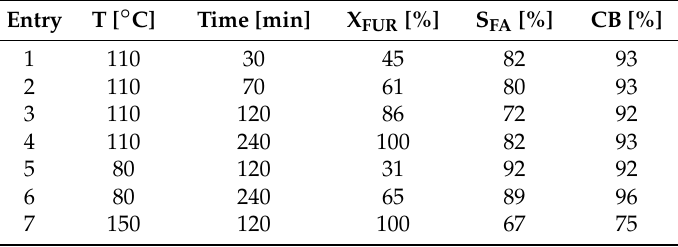
Figure 3. The furfural oxidation reaction on different MnO 2 oxides and Au modified samples: P = 12 bar (air), T = 110 °C, reaction time 2 h, furfural:Au molar ratio = 100:1. C stands for the furfural conversion, S for the selectivity in furoic acid and Y for the yield of furoic acid, respectively. Table 2. Screening of the catalytic conditions using Au/MnO 2 -NF catalyst. P = 12 bar (air), furfural:Au molar ratio = 100:1.